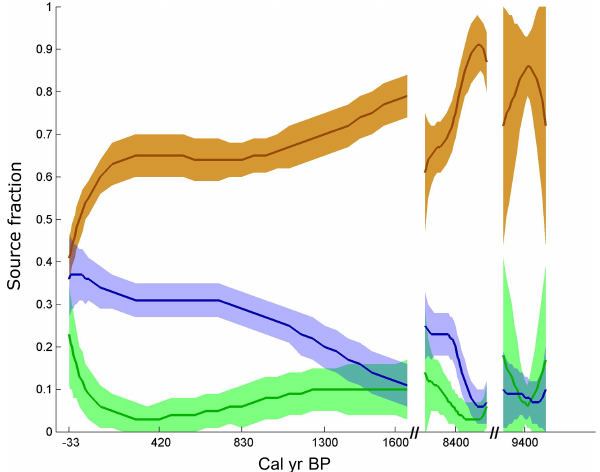
Figure 5. Dual-carbon isotope ( δ 13 C, (cid:49) 14 C) composition of the sediment cores GC58 (this study) and PC23 (Tesi et al., 2016a). Topsoil-PF refers to organic matter from the active layer of per- mafrost, ICD-PF to relict Pleistocene Ice Complex deposit per- mafrost (yedoma) and marine OC to organic matter from primary production. The endmember values for different sources are taken from a dataset compiled by Vonk et al. (2012) and a study by Smith et al. (2002). The green arrow points to the direction from the bot- tom to the top of the core